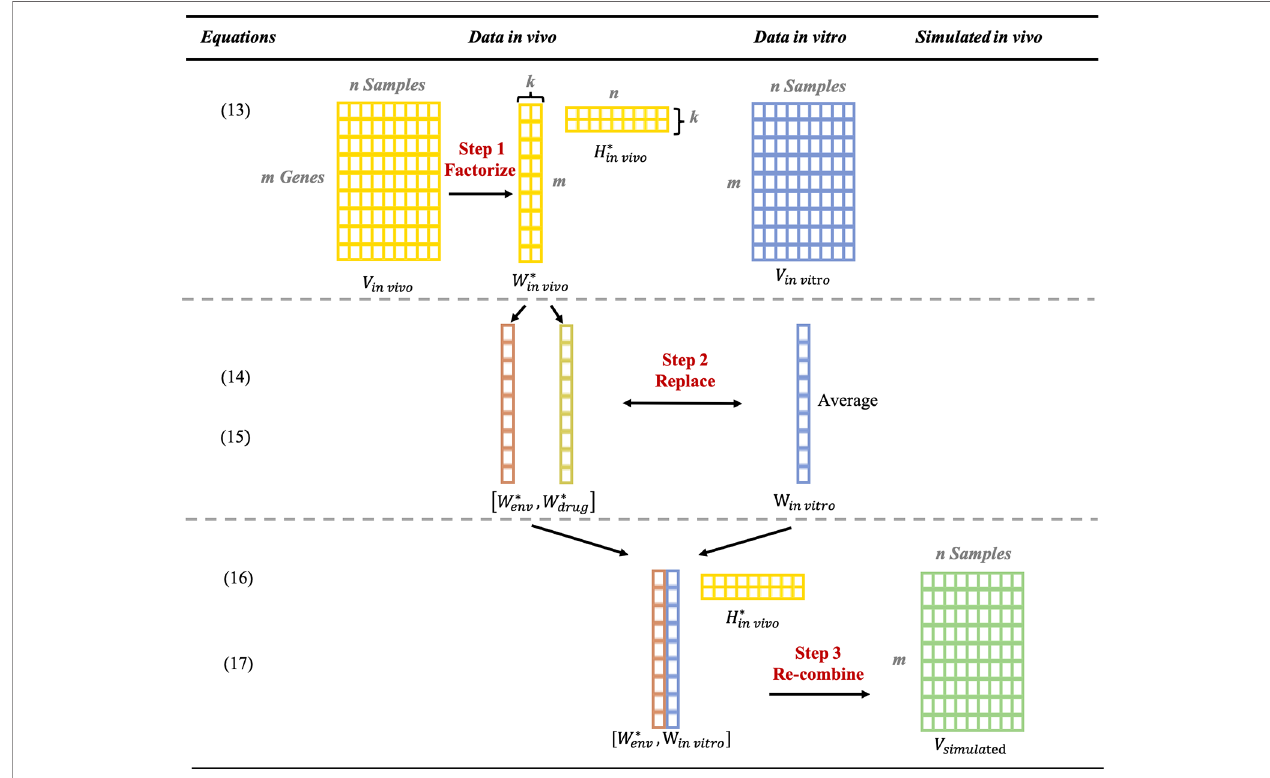
FIGURE 6 | Step by step illustration of generating the simulated in vivo data by combining in vitro data with environmental component from in vivo